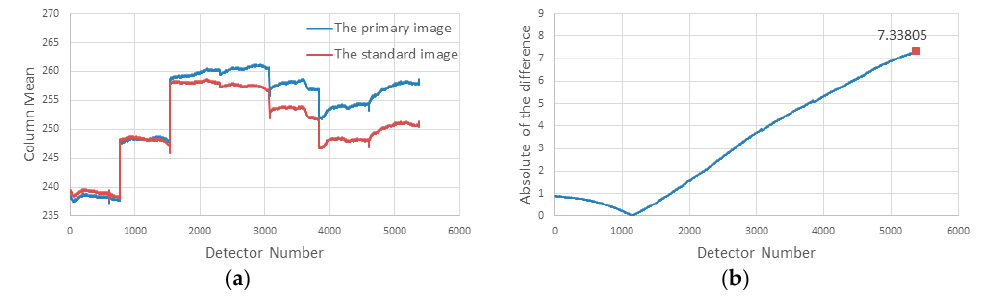
Figure 17. Changes in column means of the primary image and standard image. ( a ) Column means of the primary and standard images; ( b ) the absolute value of the difference between column values of the primary and standard